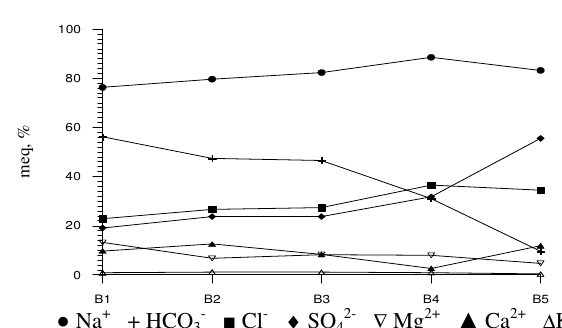
Figure 3. Changes of concentration of major species in meq% along flow path